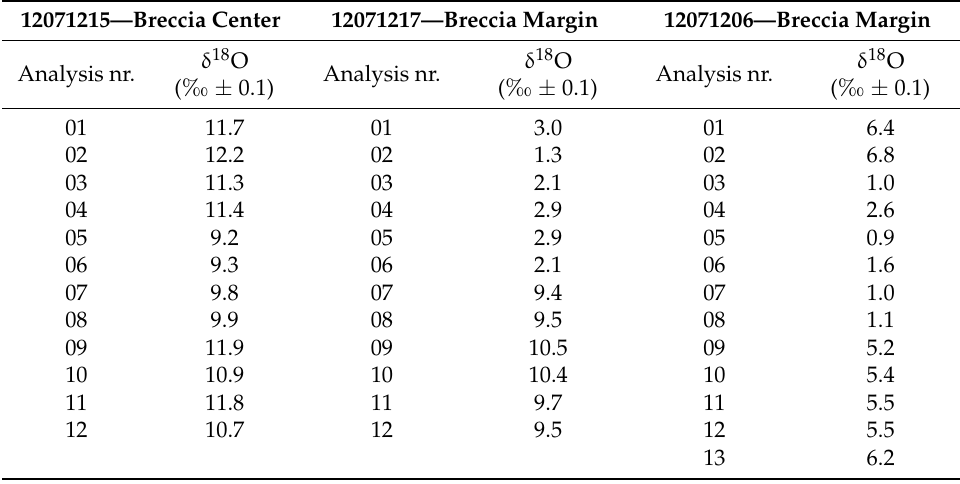
Table 6. Results of oxygen isotope microanalyses by SIMS on selected hydrothermal quartz crystals (samples 12071206, 12071215, 12071217).